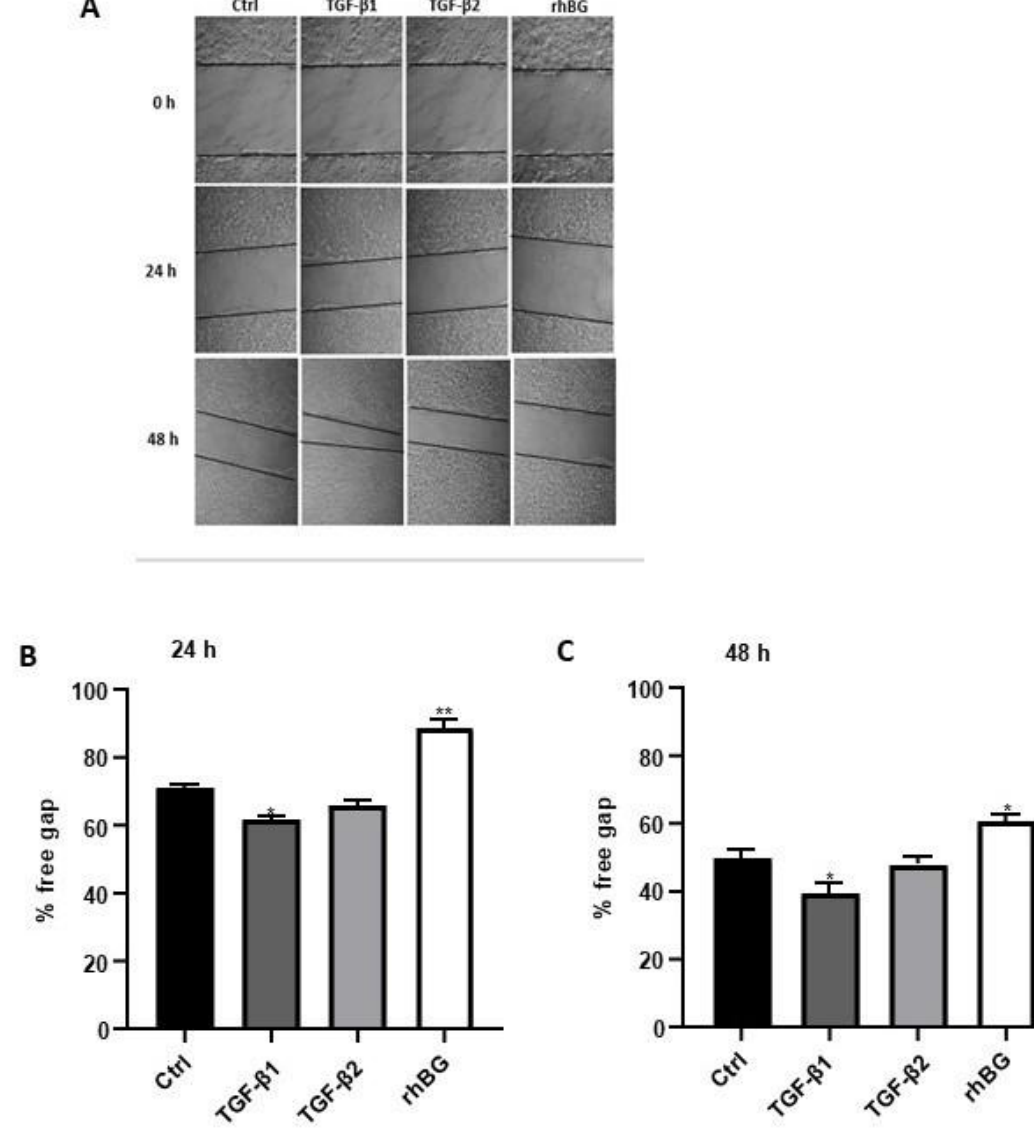
Figure 7. Effects of TGF- β 1/ β 2 and BG on wound healing of 12Z cells were monitored by taking images at three different time points. Cells were cultured in 6-well plates and the confluent cell monolayer disrupted by scratching with a pipette tip. Cells were stimulated with or without 10 ng/mL TGF- β 1, - β 2 or 25 ng/mL rhBG and cell-free areas monitored at 0, 24, and 48 h by capturing images as described in methods ( A ). The results are presented as a percentage of the free gap following treatment with TGF- β 1/ β 2 or rhBG using the ImageJ program analysis after 24 ( B ) and 48 ( C ) h. TGF- β 1 but not TGF- β 2 promoted migration of the endometriotic cells, whereas rhBG reduced migration of the cells. Each bar represents the mean ± SEM of three independent experiments performed in duplicate. * p ≤ 0.05; ** p < 0.01; rhBG, recombinant human betaglycan; Ctrl, control.